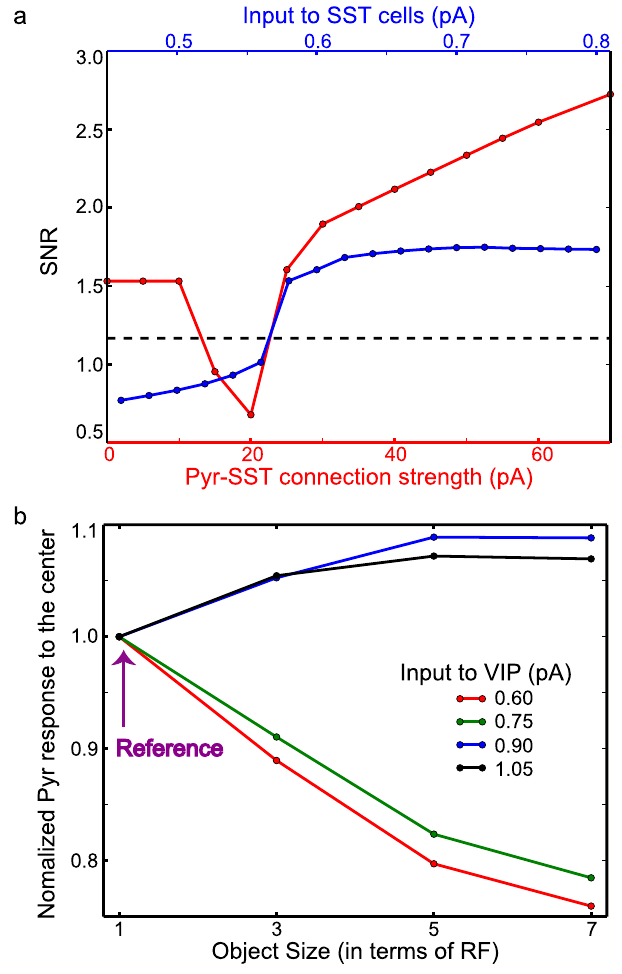
Figure 3. The functions of surround suppression and its modulation. ( a ) Pyr cell responses in population 4, compared with other Pyr cell responses elicited by background input only. SNR is the normalized population 4 responses to the mean activity of all other populations. The dependency of SNR on the input to SST cells and the IPPS strength are shown in blue and red, respectively. The dashed line represents the SNR of inputs to Pyr cells. ( b ) The modulation of surround suppression via VIP cell depolarization. y -axis represents Pyr cell responses to the center of the object depending on its size. For a fixed input to VIP cells, we set the Pyr cell responses to the narrow object, whose width is 1-RF long, as reference values, which we use to normalize Pyr cell responses. The background inputs to VIP cells are 0.6, 0.75, 0.9 and 1.05 pA, which are shown in red, green, blue and black,